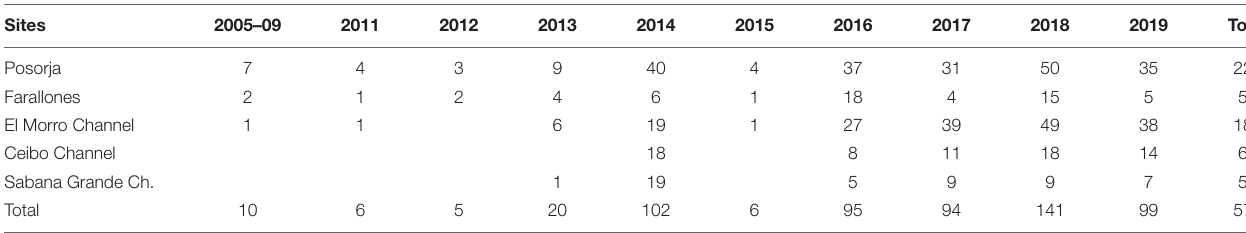
TABLE 2 | The number of times sites and channels surveyed within the study